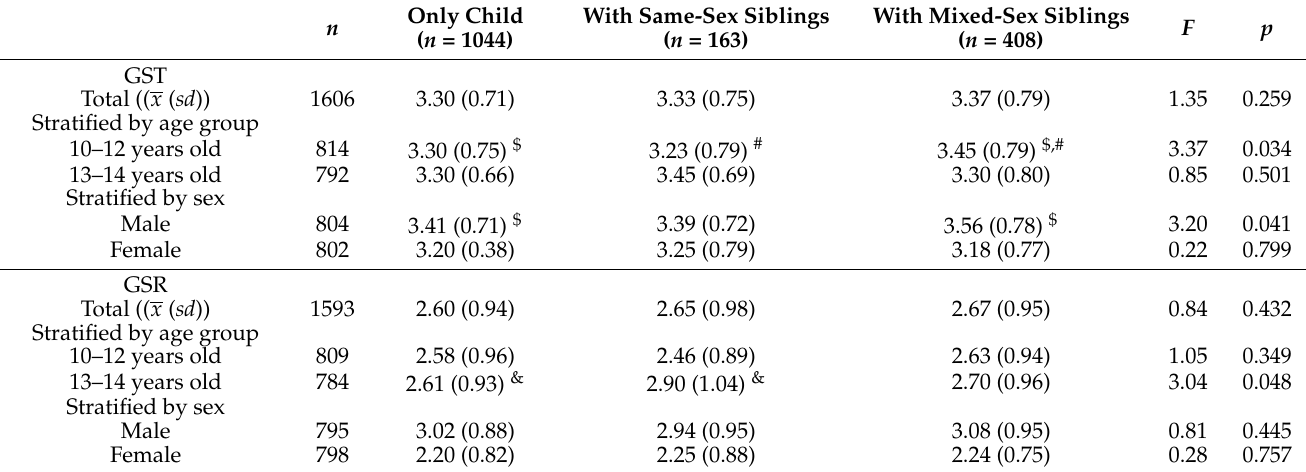
Table 3. Mean scores ( x ( sd )) for gender norms scales of participants by different sibling contexts, stratified by sex and age